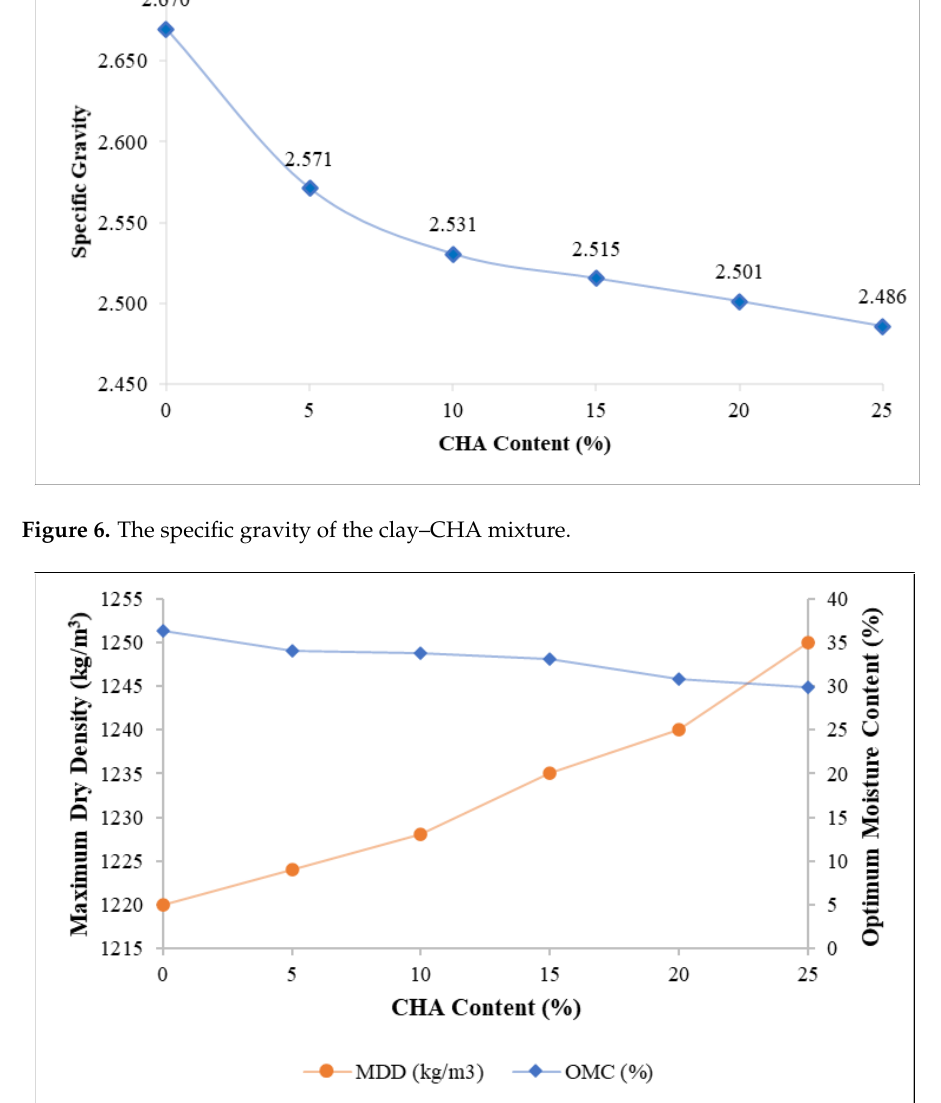
Figure 7. Compaction parameter of the clay – CHA mixture.